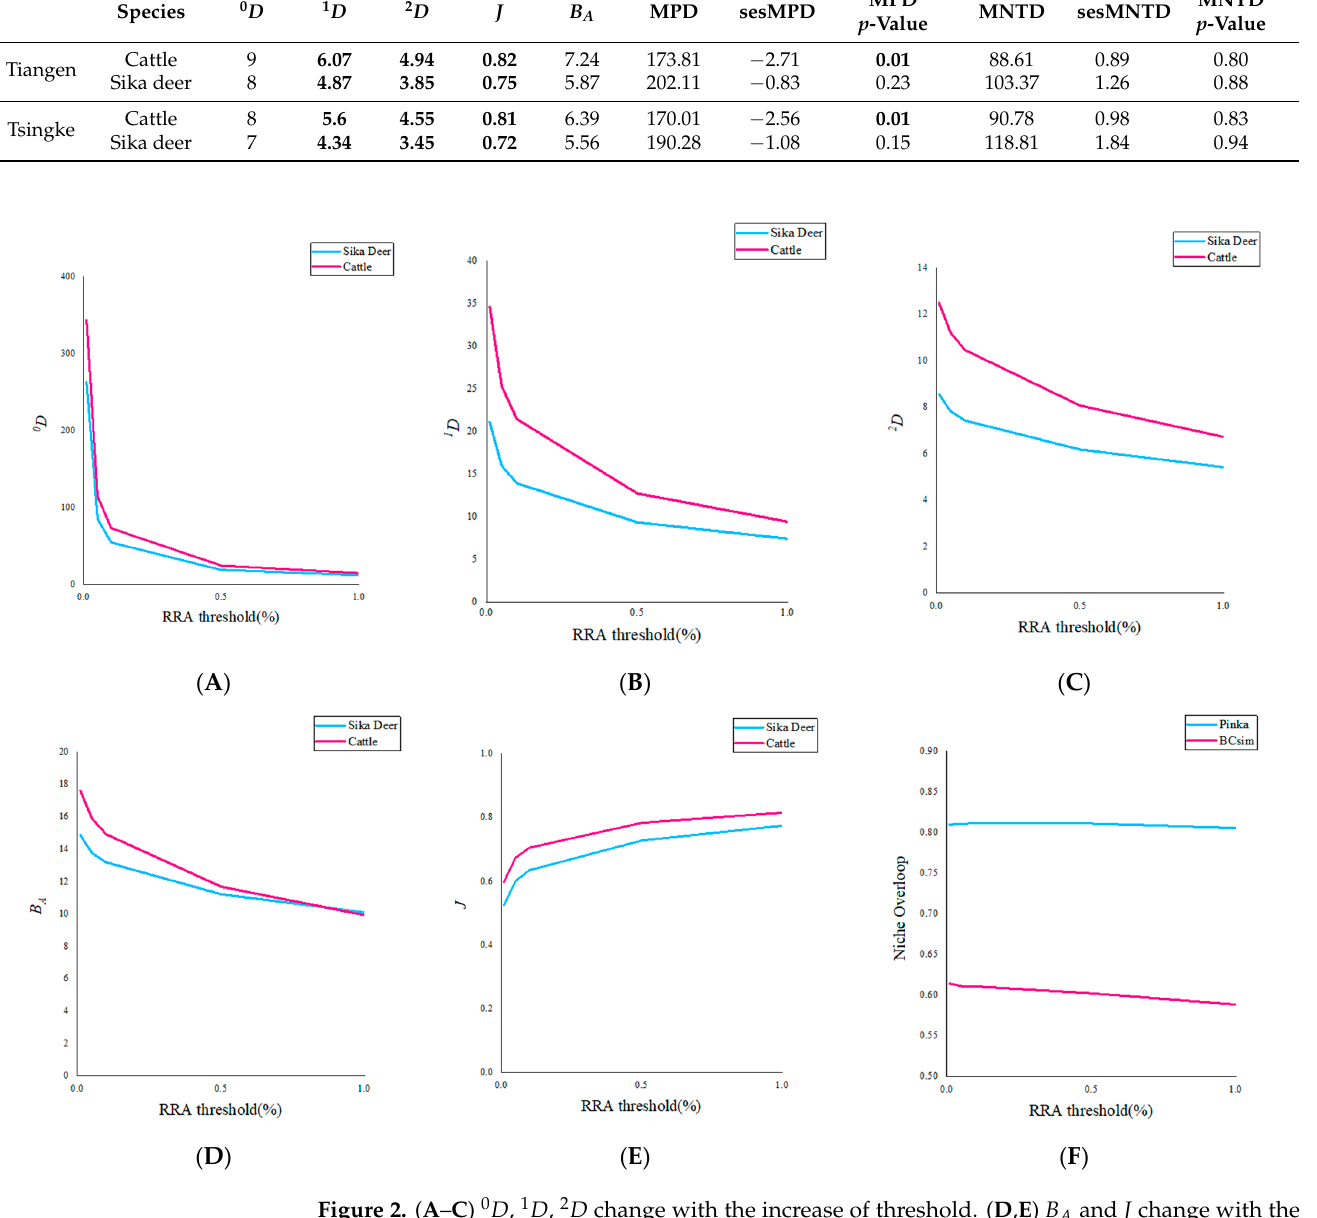
Figure 2. ( A – C ) 0 D , 1 D , 2 D change with the increase of threshold. ( D , E ) B A and J change with the increase of threshold. ( F ) Two indices of niche overlap of cattle and sika deer varied with